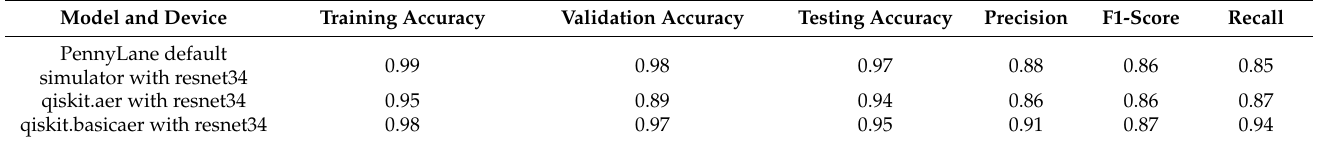
Table 4. Results of quantum transfer learning model using the balanced dataset.